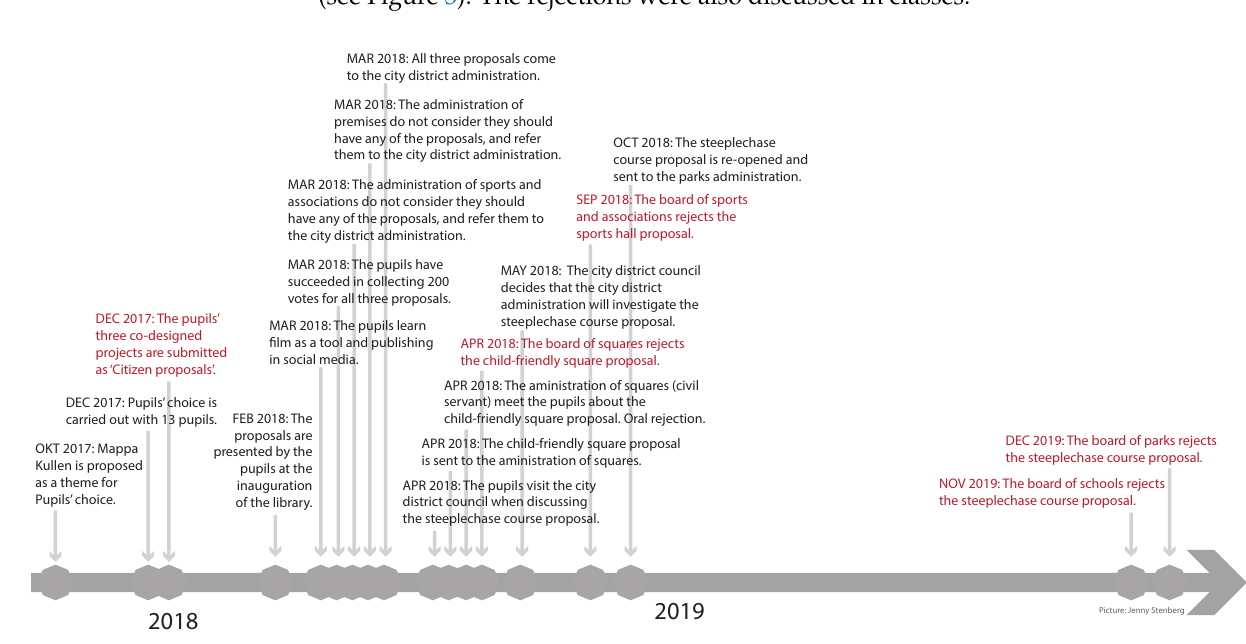
Figure 3. The timeline of pupil’s